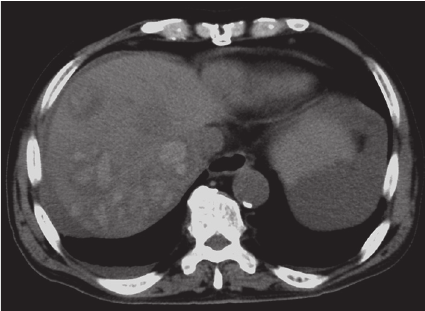
Figure 2: Nonenhanced computed tomography image. High-at- tenuation areas were observed in multiple HCCs considered to indicate multiple intratumoral hemorrhages.